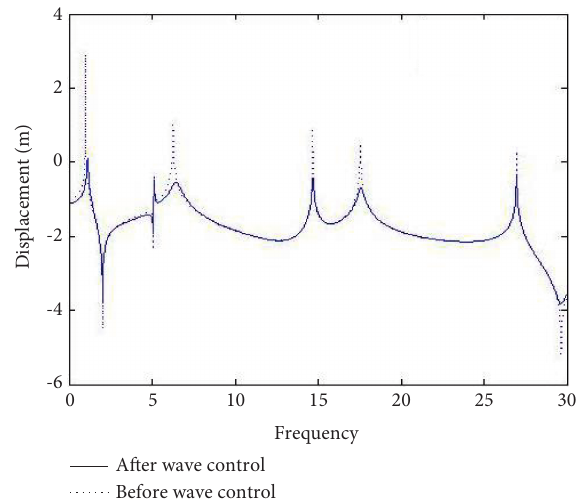
Figure 6: Frequency response before and after wave control.